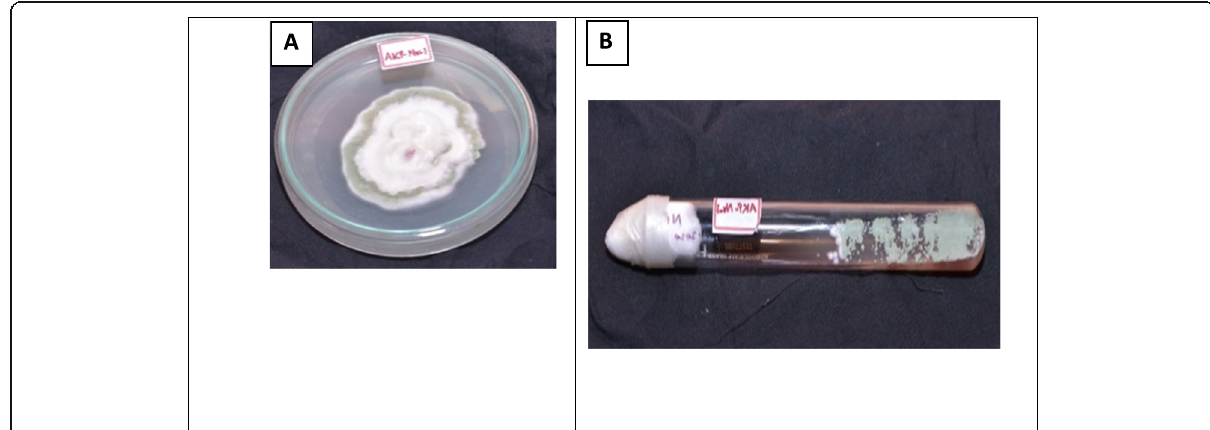
Fig. 3 In vitro growth of Nomuraea rileyi on SMYAmedium. a Growth of fungal hyphae (white in colour) and b spore production (green in